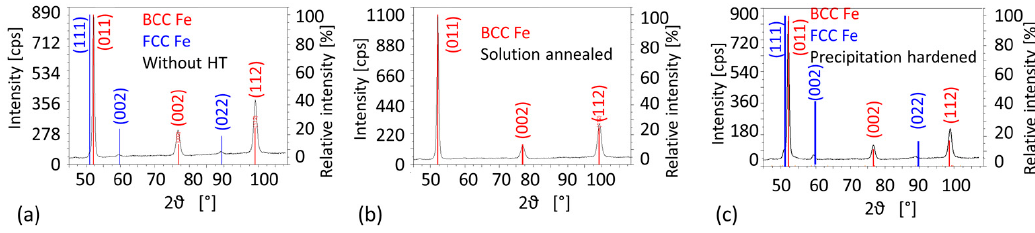
Figure 9. X-ray diffraction (XRD) spectra of additively manufactured (AM) steel: ( a ) without heat treatment (HT); ( b ) solution Figure 9. X ‐ ray diffraction (XRD) spectra of additively manufactured (AM) steel: ( a ) without heat Figure 9. X ‐ ray diffraction (XRD) spectra of additively manufactured (AM) steel: ( a ) without heat annealed; ( c ) precipitation hardened. Body centered cubic lattice of ferrite (BCC Fe), Face centered cubic lattice of austenite treatment (HT); ( b ) solution annealed; ( c ) precipitation hardened. Body centered cubic lattice of treatment (HT); ( b ) solution annealed; ( c ) precipitation hardened. Body centered cubic lattice of (FCC ferrite (BCC Fe), Face centered cubic lattice of austenite (FCC Fe). ferrite (BCC Fe), Face centered cubic lattice of austenite (FCC Fe). Figure 9. X ‐ ray diffraction (XRD) spectra of additively manufactured (AM) steel: ( a ) without heat treatment (HT); ( b ) solution annealed; ( c ) precipitation hardened. Body centered cubic lattice of ferrite (BCC Fe), Face centered cubic lattice of austenite (FCC Fe).